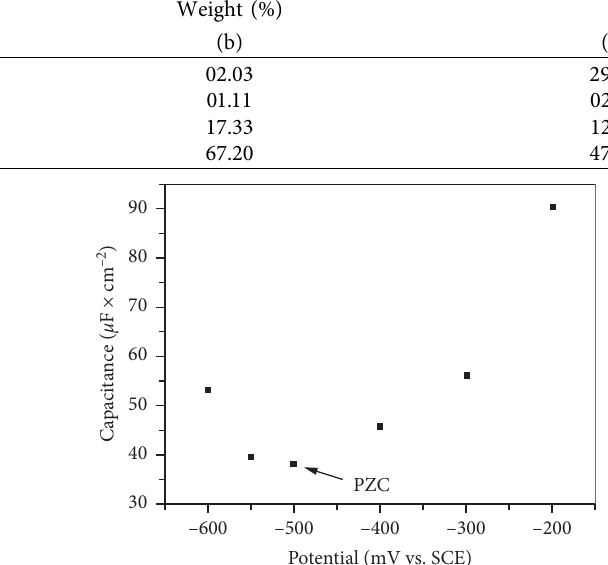
Table 7: Weight percentage of SS alloying elements of (a) freshly polished specimen surface, (b) exposed to 1M H 1M H 2 SO 4 containing 10 − 3 M of ACM.